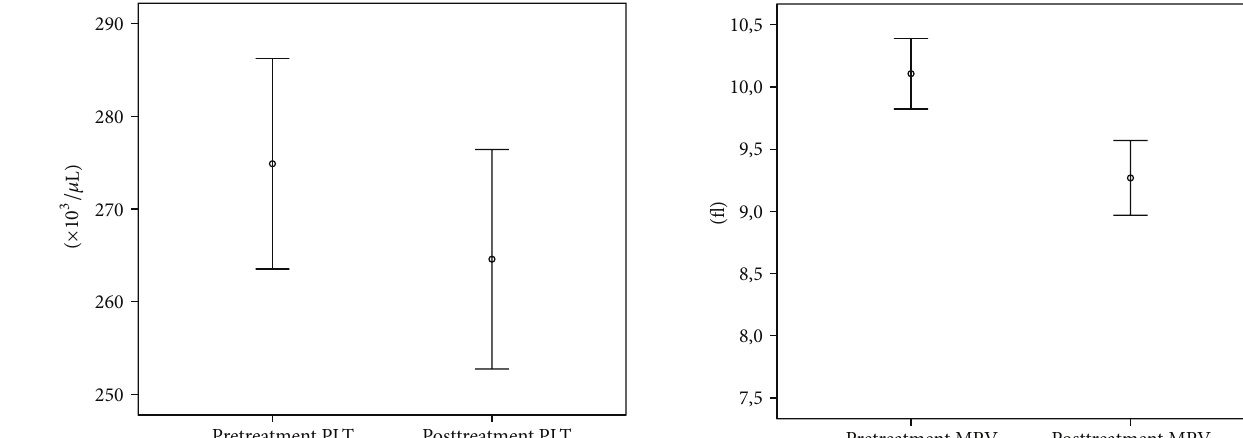
were included in this retrospective study. The laboratory findings (hemoglobin (Hb), hematocrit (Htc), platelet count (PLT), mean platelet volume (MPV), and white blood cell (WBC)) prior to and three months following the study were recorded from the patient files. All of the patients received daily isotretinoin at a dose of 0.5–1 mg/kg for at least 3 months. Data were expressed as mean ± standard deviation.